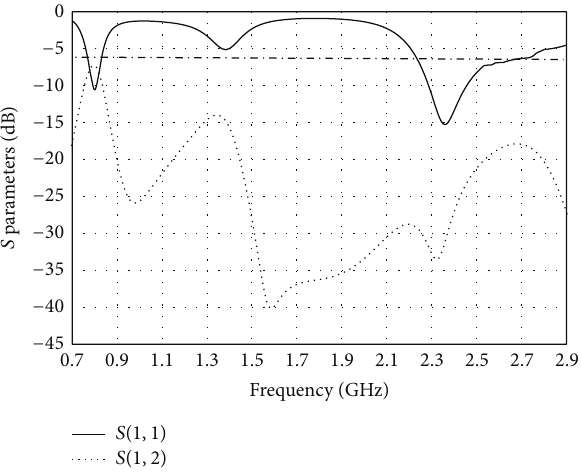
Figure 5: 𝑆 11 and 𝑆 12 (dB) for the proposed